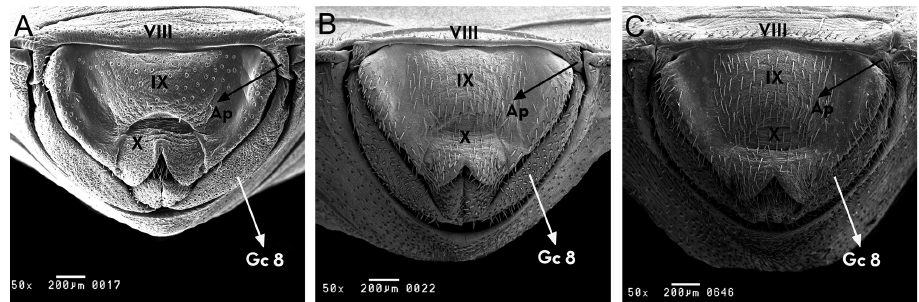
Figure 10. Female external genitalia, posterior side of R. marabaensis sp. n. ( A ), R. prolixus ( B ), R. ro- bustus ( C ). Ap: appendices; Gc 8: gonocoxite VIII; Gp 8: gonaphofyse VIII; VII, VIII, IX: tergites; X: